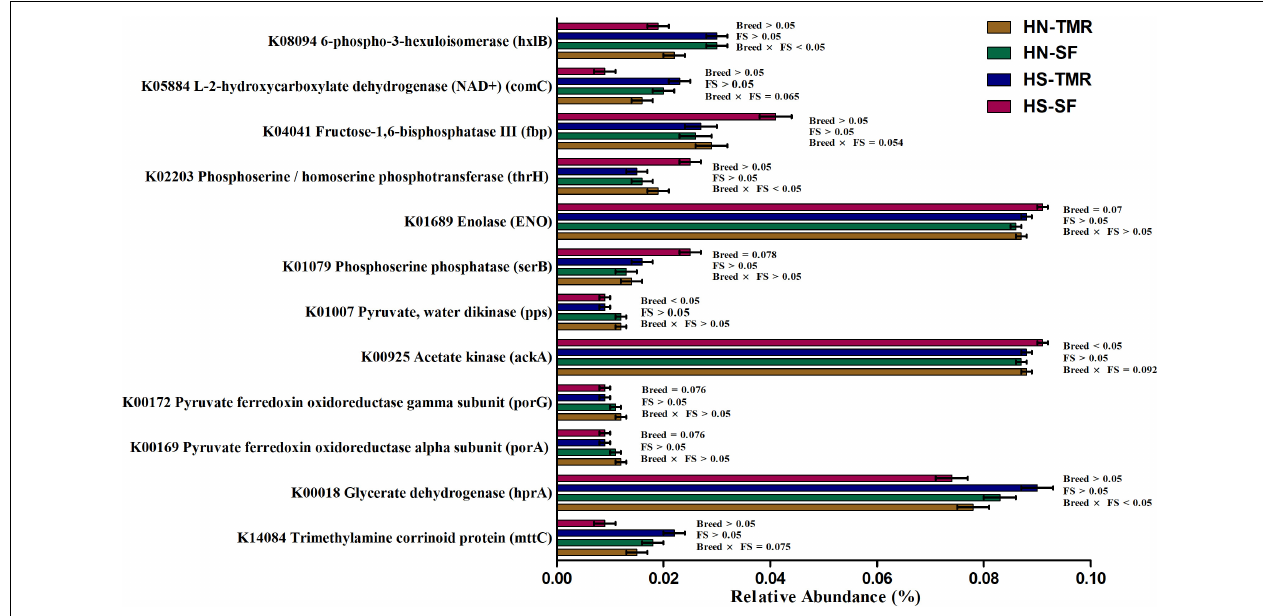
FIGURE 8 | The metagenomic abundance of key genes involved in the methane metabolism pathway that tend to differ (0.05 < P < 0.1) or were significantly different ( P < 0.05) between Hanwoo (HN) and Holstein (HS) steers fed a total mixed ration (TMR) or separate feed (SF)